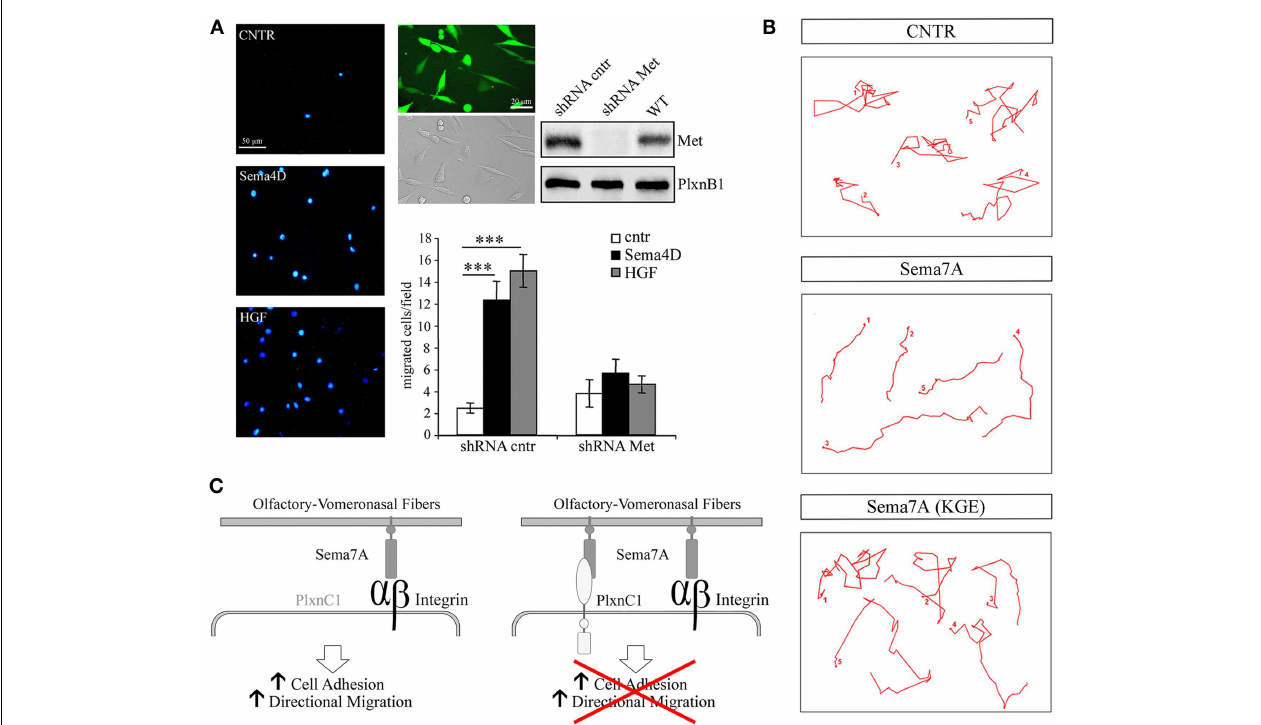
Boyden’s chamber experiments. shRNA cntr cells or shRNA Met cells were treated with 5nM Sema4D or 0.5nM HGF. GN11 cells in which Met was silenced were unable to migrate toward a Sema4D gradient. Results are expressed as mean ± SEM. *** P < 0.0001 from two-way ANOVA. (B) Representative images from time-lapse videos at different time points show GN11 neurons migrating farther onto Sema7A-coated stripes than onto Sema7A(KGE)-coated stripes as a consequence of increased persistence. The movement of individual cells was recorded during 6h and plotted. (C) Schematic representation of Sema7A function on the GnRH migratory behavior: Sema7A is expressed along the developing olfactory/vomeronasal axons and acts on GnRH neurons increasing adhesion and persistent migration through β 1-integrin binding and activation. Expression of PlexinC1 in GnRH neurons switches off their migratory response to Sema7A. Reprinted with permission from (14,